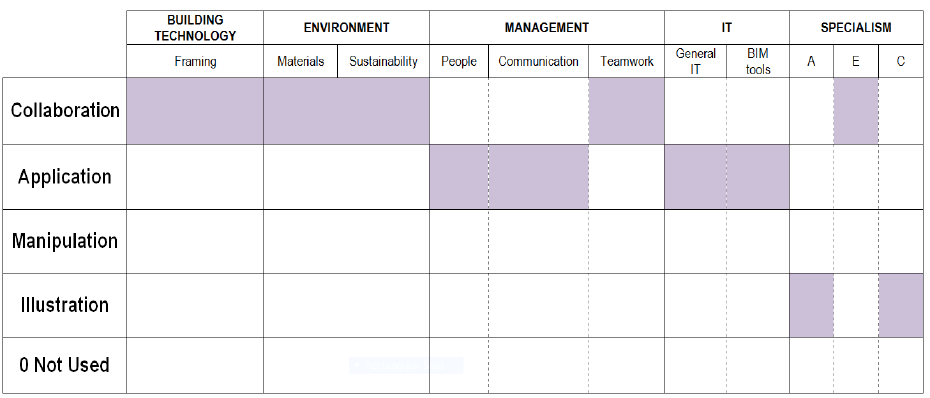
Figure 4 IMAC chart for an Engineering Course (suggested Target Levels